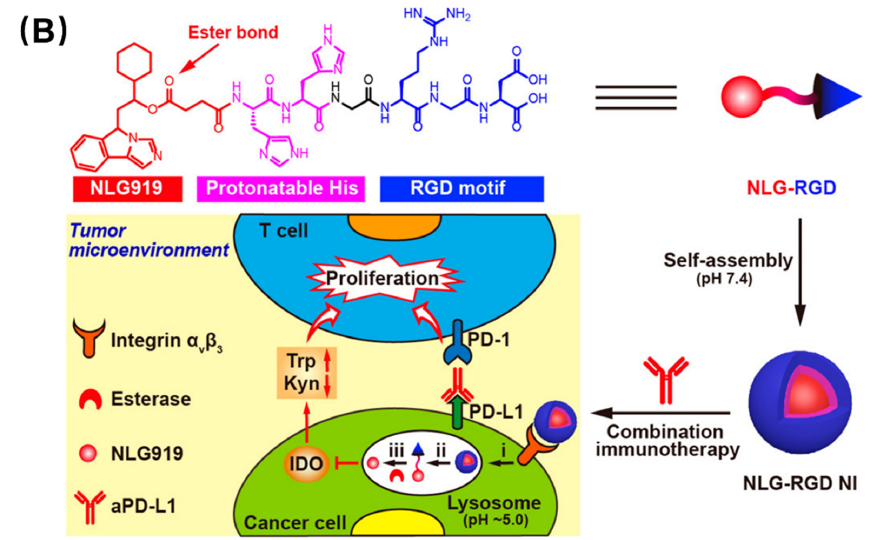
Figure 4. Synergistic nanoparticles blocked both PD-L1 and IDO to enhance tumor immunity. ( A ) DEAP- D PPA-1 and NLG919 coassembled into a nanoparticle which swelled in response to tumor acidity and dissociated through MMP-2 cleavage. Thereafter, NLG919 and D PPA-1 were released to target IDO and PD-L1, respectively. Reproduced from Reference [37] with permission. Copyright: 2018 American Chemical Society. ( B ) Modularly designed, self-assembled peptide–drug conjugate NLG-RGD augmented antitumor immunity of PD-L1 checkpoint blockade by targeting IDO. It was self-assembled from a modularly designed peptide − drug conjugate containing a hy- drophilic targeting motif RGD, two protonatable histidines, and an ester-bond-linked hydrophobic IDO inhibitor. It achieved potent and persistent inhibition of intratumoral IDO activity with a re- duced systemic toxicity. Reproduced from Reference [38] with permission. Copyright: 2020 Ameri- can Chemical Society.